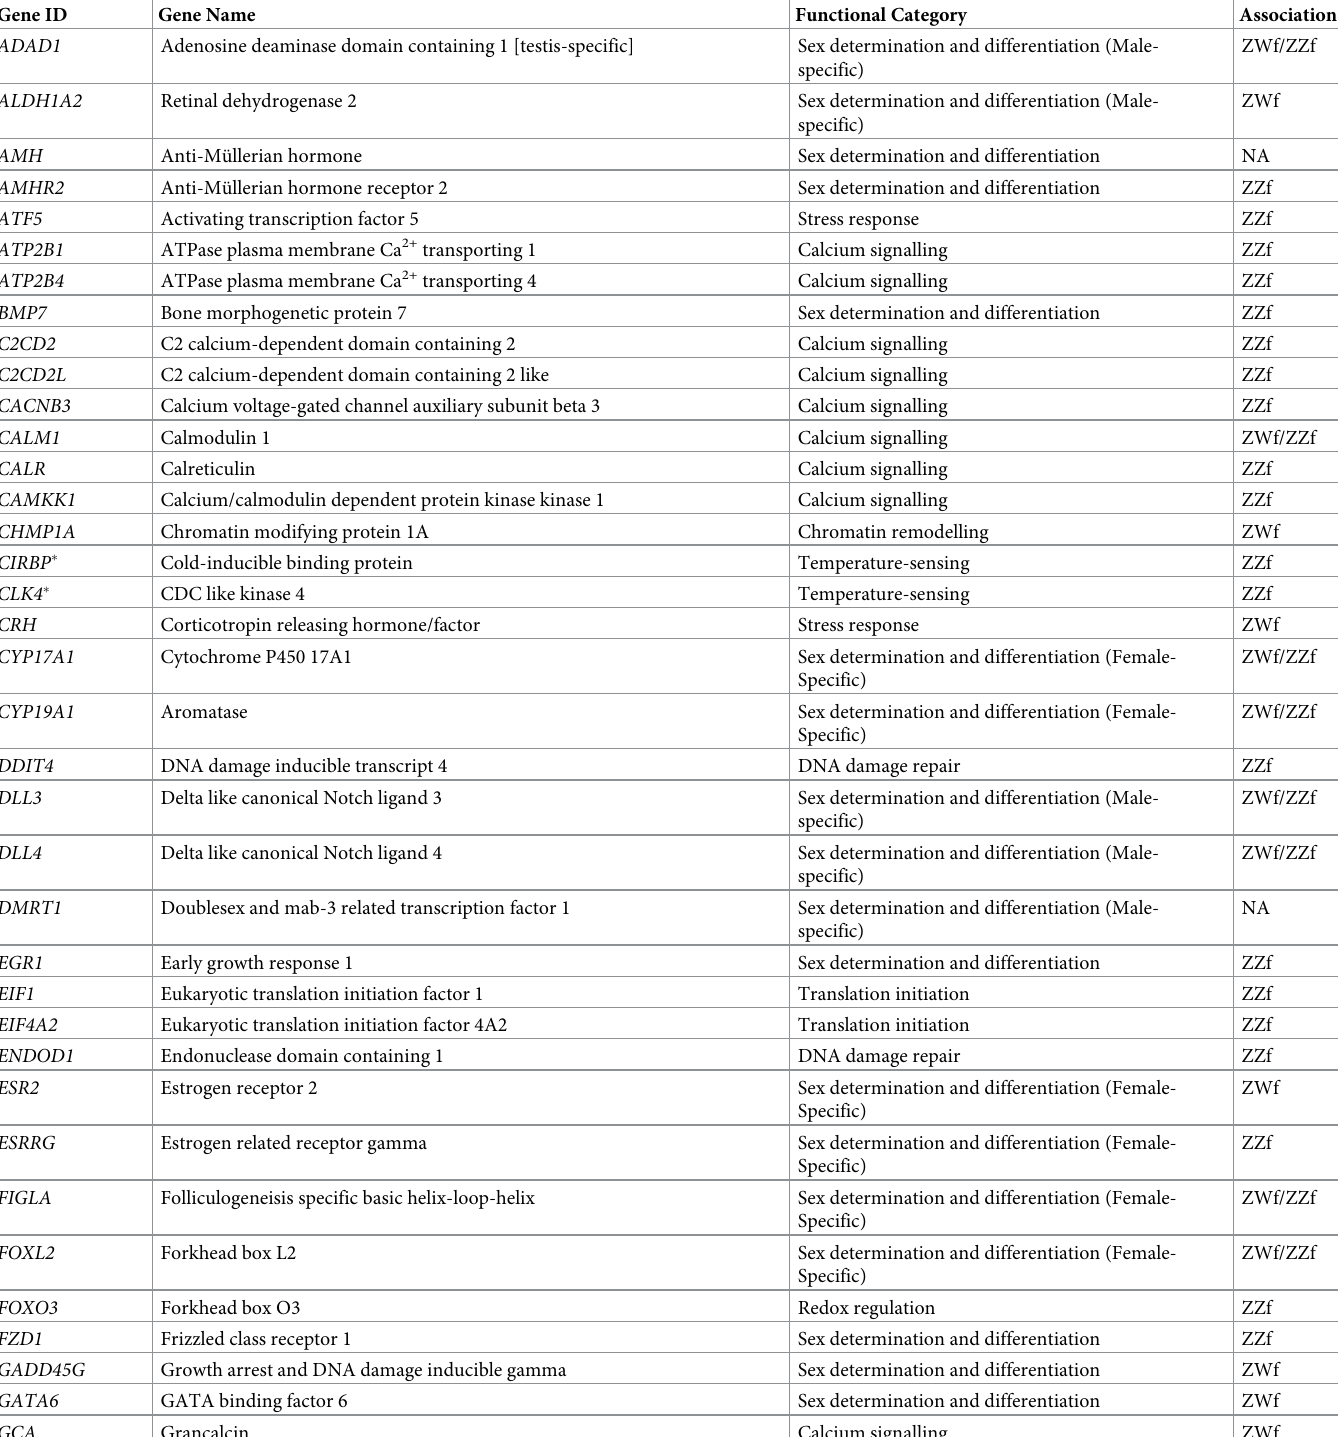
Table 1. All genes, full gene names, functional categories and associations with either gene (ZWf) or temperature driven (ZZf) female development mentioned in the paper. NA denotes a gene that was mentioned, but was not differentially expressed. Genes with an asterisk are those that have previously been implicated in thermo- sensitive sex determination cascades, either in Pogona vitticeps , or in another reptile species.